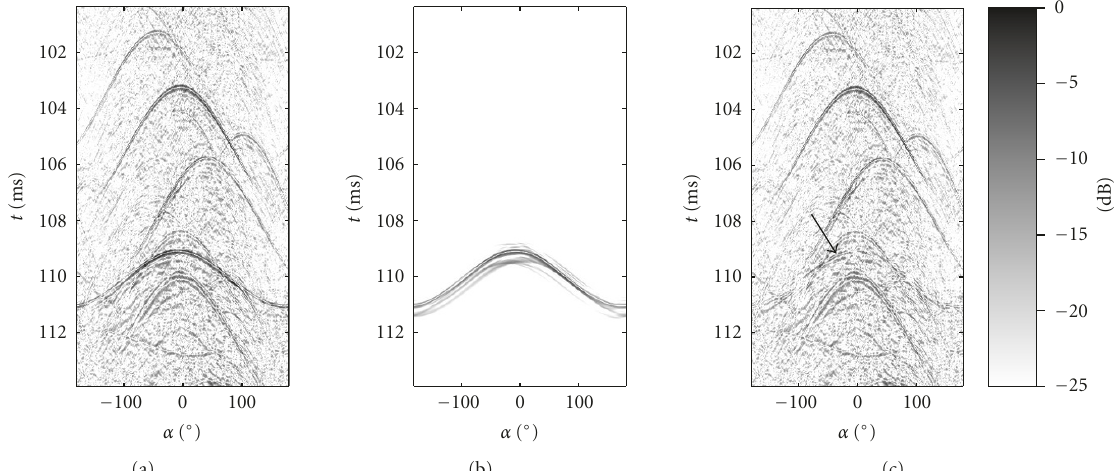
Figure 12: (a) Detail of the measured data set of Figure 4, (b) reconstruction of the response of the first-order ceiling reflection using the Radon transform method, (c) the result of subtracting (b) from (a).